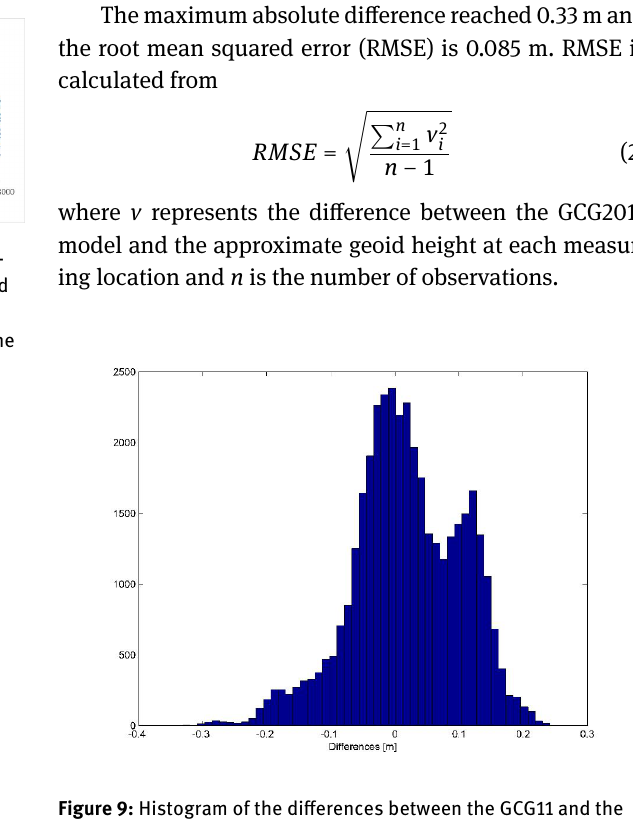
Figure 9: Histogram of the differences between the GCG11 and the approximated calculated geoid